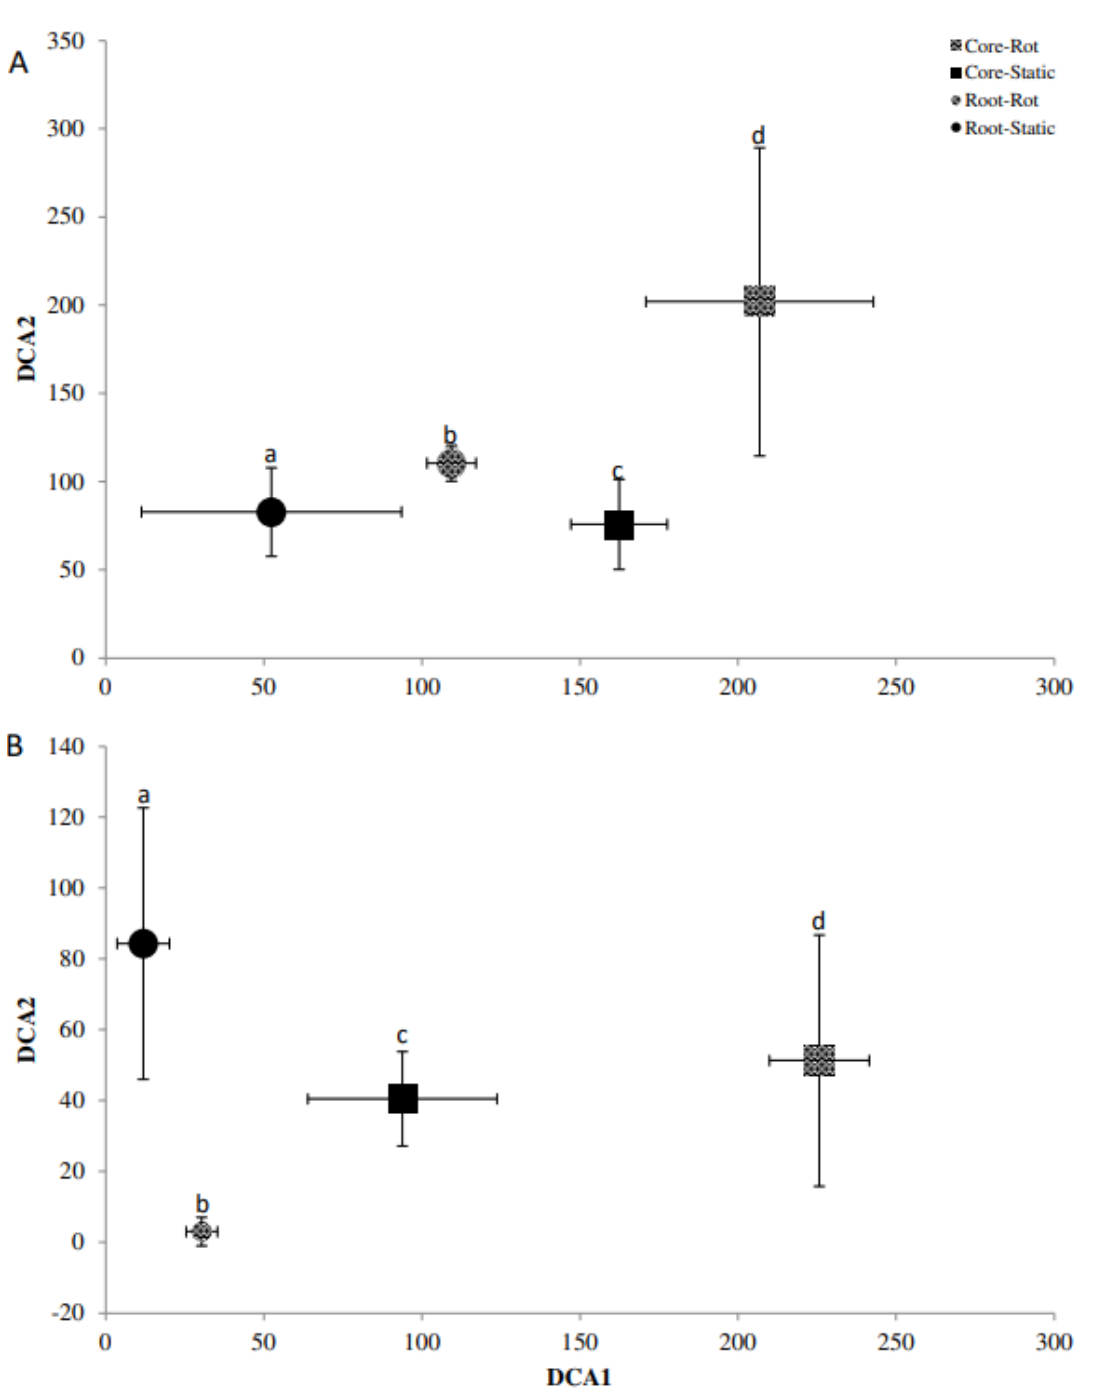
Figure 3. Detrended correspondence analysis (DCA) bi-plot of the 18S AM fungal community fingerprint for Agrostis stolonifera ( A ) and Plantago lanceolata ( B ). DCA1 = Axis 1, DCA2 = Axis 2. Treatments; roots = circle, cores = square, static (Static) = solid, rotating (Rot) = pattern. Letters (a–d) indicate significant differences; error bars represent standard deviation among replicates.